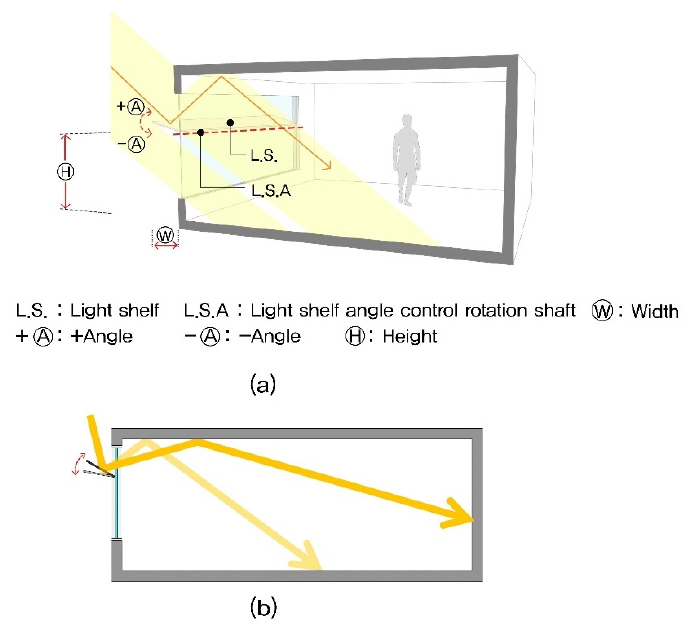
Figure 1. Light shelf concept and operation: ( a ) Concept and variables, ( b ) Inflow of the natural light by manipulating angle of the light shelf.